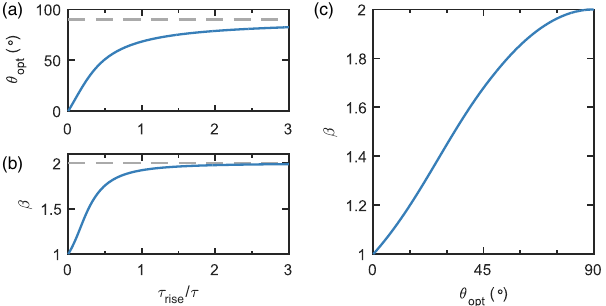
FIG. 7. Dependence of the NV phase response on the photo- current rise time. (a) Analytic value of optimal delay θ for an opt exponential rise and fall signal, as a function of the normalized = τ . The limit τ → 0 is a square wave signal, rise time, τ rise rise → ∞ represents a triangle wave signal, where θ whereas τ rise opt = Φ as a function approaches 90°. (b) Analytic value of β ∝ B max of rise time. In the limit of a triangle wave signal, β approaches 2. (c) β determined from θ using (a) and (b). The factor β allows opt the amplitude of the field B , reached at the end of the pulse, to max be determined from the time-integrated phase Φ accumulated by the NV